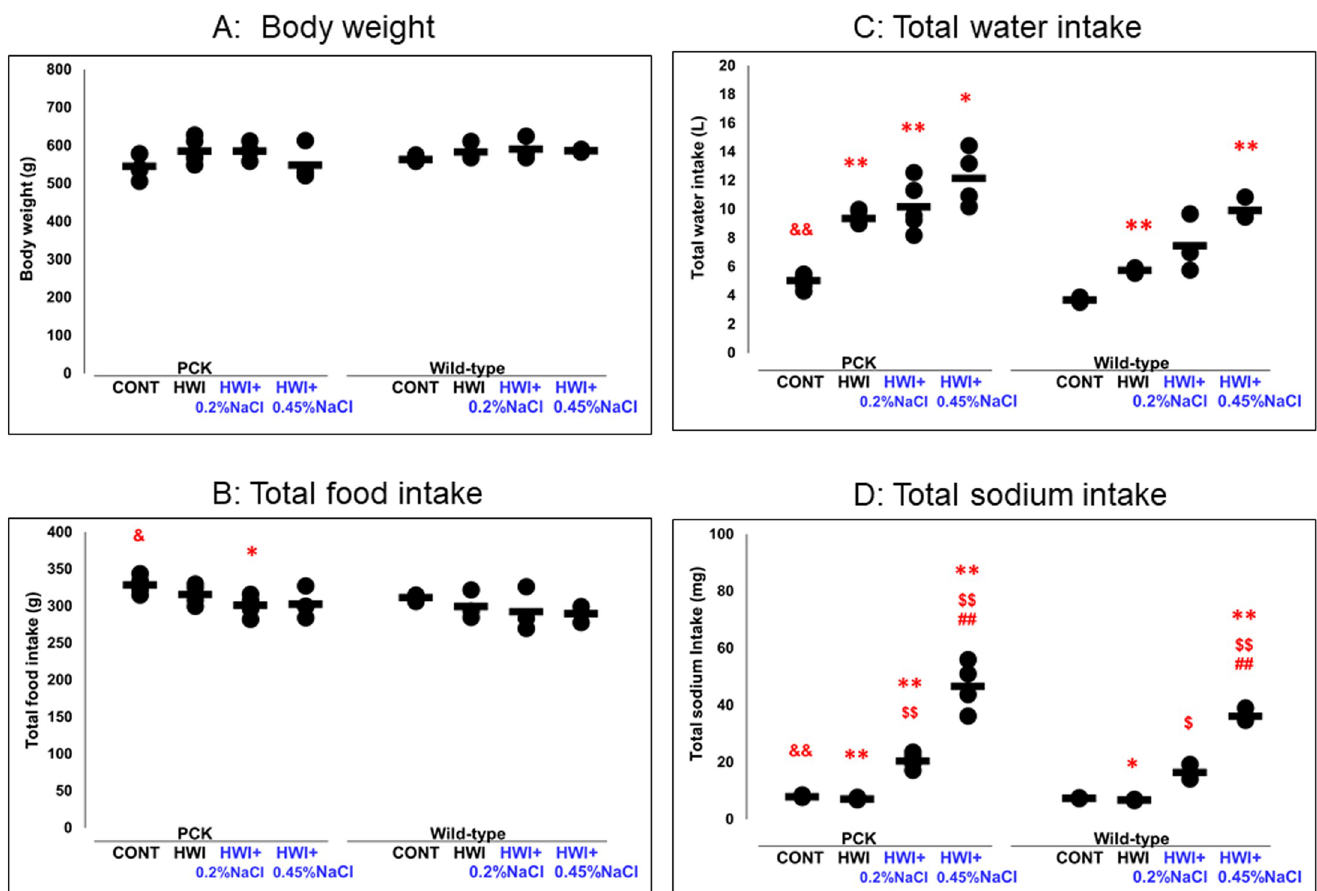
Fig 1. Effects of HWI and NaCl overload on body weight and total intake of food, water, and sodium. CONT, distilled water group; HWI, high water intake group (5% glucose); HWI+0.2%NaCl, high water intake with 0.2% NaCl group; HWI+0.45%NaCl, high water intake with 0.45% NaCl group. Difference between PCK CONT and wild-type CONT groups: &, P < 0.05; &&, P < 0.01. Comparison between CONT and treated groups: � 1, P = 0.050; � , P < 0.05; �� , P < 0.01. Comparison between HWI and HWI+0.2%NaCl or HWI+0.45%NaCl: $, P < 0.05; $$, P < 0.01. Comparison between HWI+0.2%NaCl and HWI+0.45%NaCl: ##, P <